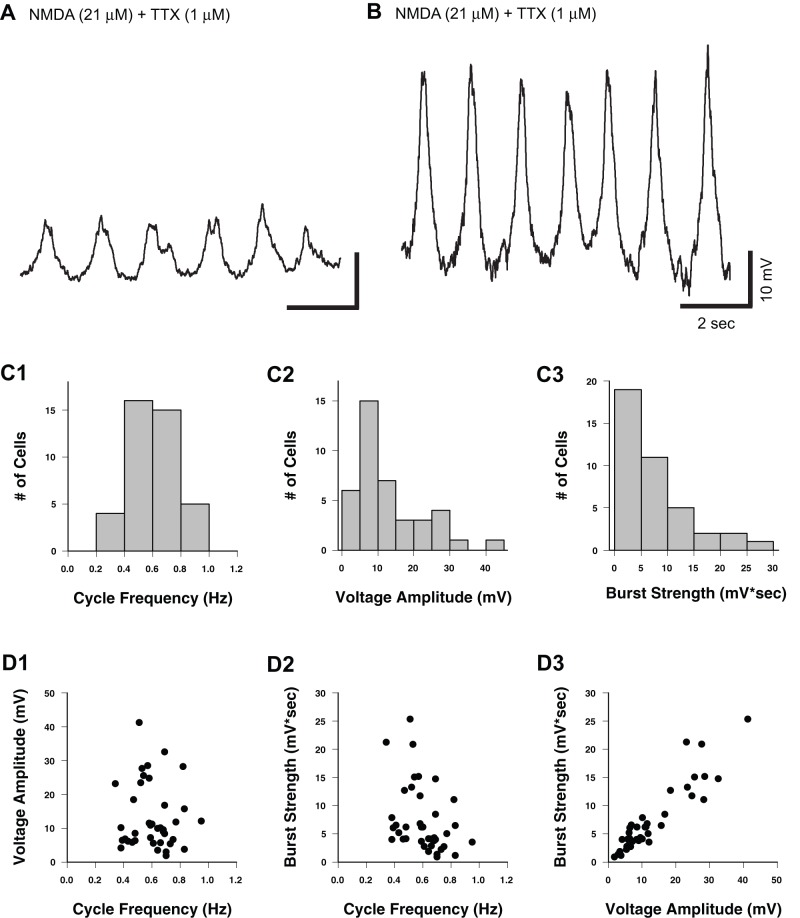
Distribution of cycle frequency and voltage amplitude for NMDA-induced membrane potential oscillations in Hb9 interneurons. A–B,Whole-cell current-clamp recordings of membrane potential from different Hb9 interneurons demonstrate variability of voltage amplitudes in NMDA induced oscillations. C1–3, Distribution plots of cycle frequency, voltage amplitude and burst strength. D1–3, There is no correlation between voltage amplitude and cycle frequency (D1; r = −0.10, p = 0.55, n = 40). However, correlations are found between burst strength and cycle frequency (D2; r = −0.39, p = 0.01, n = 40) and burst strength and voltage amplitude (D3; r = 0.92, p<0.001, n = 40).